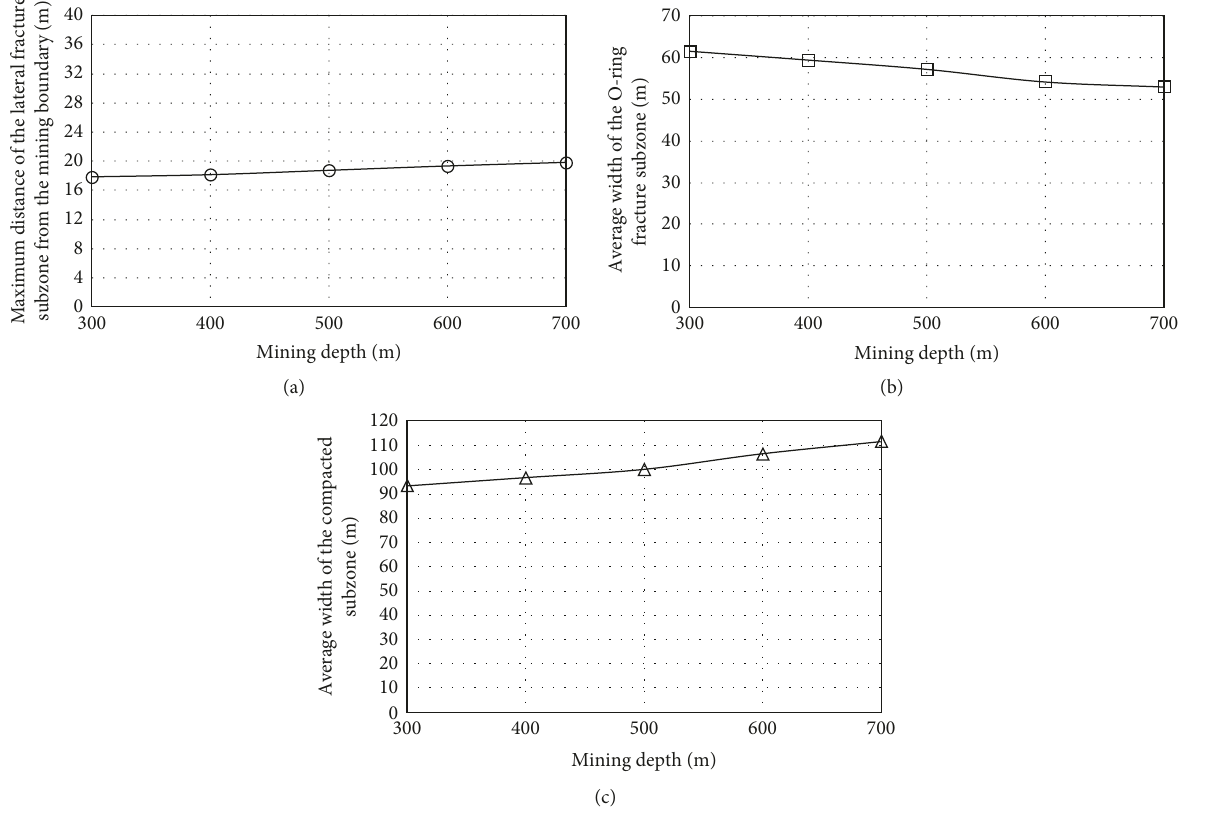
Figure 9: Laws of variation of the horizontal subzones of the GFFZ under different mining depths: (a) lateral fracture subzone; (b) O-ring fracture subzone; (c) compacted subzone.